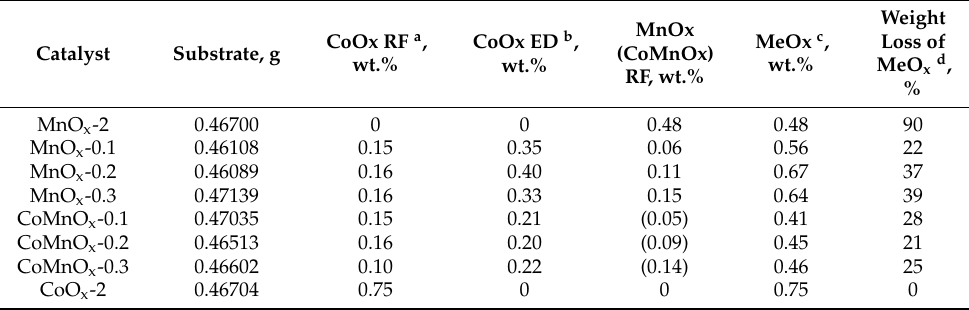
Table 1. Average amount of each layer in the catalysts (per piece of a stainless steel mesh, related to the weight of sample corresponding to a given preparation